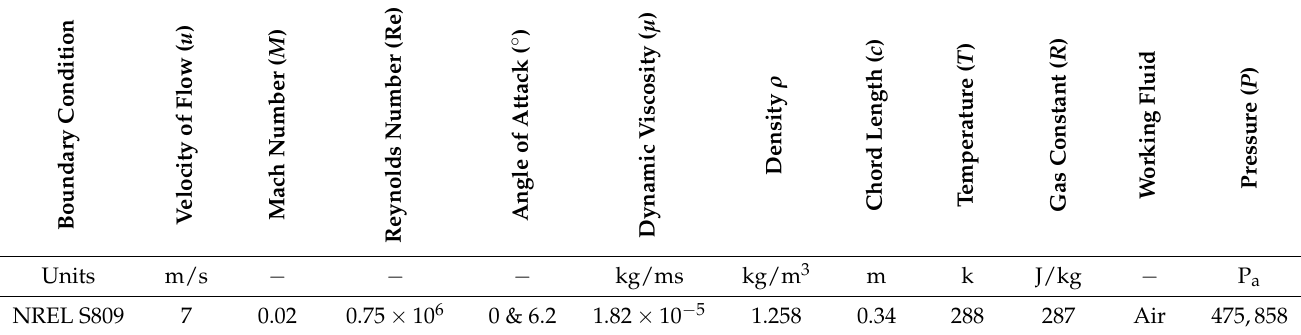
Table 3. Operating parameters for the